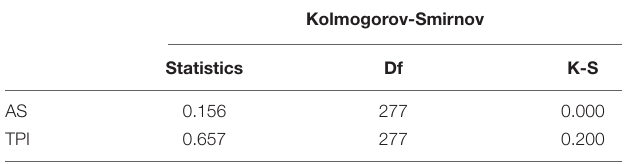
TABLE 2 | Normality test for AS and TPI.